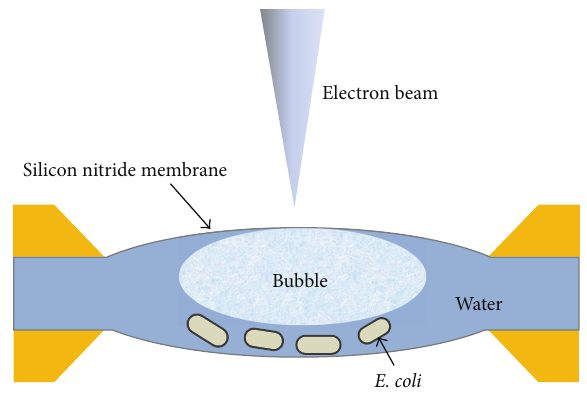
Figure 6: Schematic of the in situ liquid chamber. Liquid with E. coli cells was filled in chamber formed by two Si 3 N 4 membranes. A bubble existed in the chamber, which was benefit to high-resolution images of